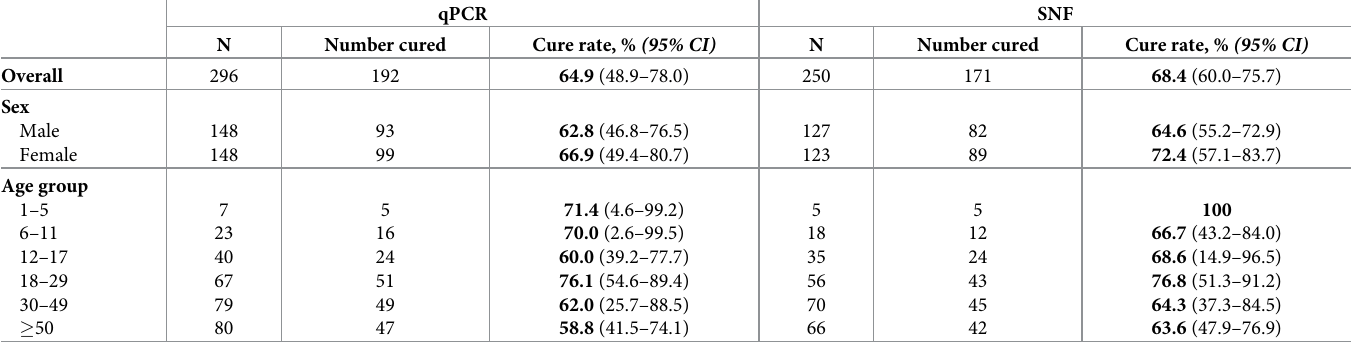
due to very low prevalence of other STH species. Ct to EPG conversion equations only available for N. americanus species of hookworm for qPCR data. N/A: Not applicable. Diagnostic agreement between qPCR and SNF The sensitivity of SNF compared with qPCR, and the diagnostic agreement between the two methods, were calculated for hookworm infection for the 743 participants who provided sam- ples before treatment, with both diagnostic results available. Sensitivity was 78.6% (235/299) for SNF compared with qPCR. The diagnostic agreement between SNF and qPCR was good ( κ = 0.77, p < 0.001) ( Table 2 ). Of note is that 16 out of 250 samples that tested positive for hookworm by SNF, before albendazole treatment, tested negative for hookworm by qPCR. These samples had a mean EPG by SNF of 40.3 EPG (range 2–273 EPG) ( Table 2 ). Conversely, there were 64 out of 296 samples that tested positive for hookworm by qPCR that were missed by SNF. The mean infection intensity of these 64 samples by qPCR was 16.5 EPG (range < 1–466 EPG), which (range < 1–36,596 EPG, p < 0.001) ( Table 2 ). Cure rate and factors associated with cure for hookworm Table 3 shows that the cure rate for hookworm by qPCR was 64.9% (adjusted 95% CI 48.9–78.0%). Cure rate by SNF was comparable ( p = 0.383) at 68.4% (adjusted 95% CI 60.0–75.7). Age, gender, and infection intensity before albendazole treatment were not associated with being cured of hookworm ( S1 Table ). Table 3. Cure rates for hookworm by qPCR and SNF overall, and by sex and age group. qPCR SNF N